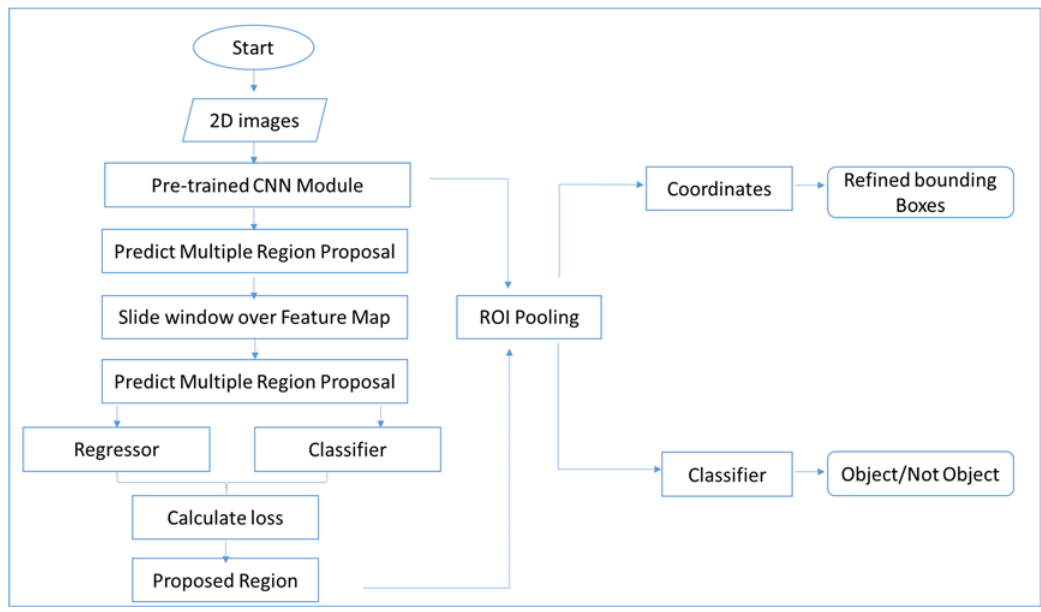
Figure 2. Block diagram of the proposed real ‐ time system.